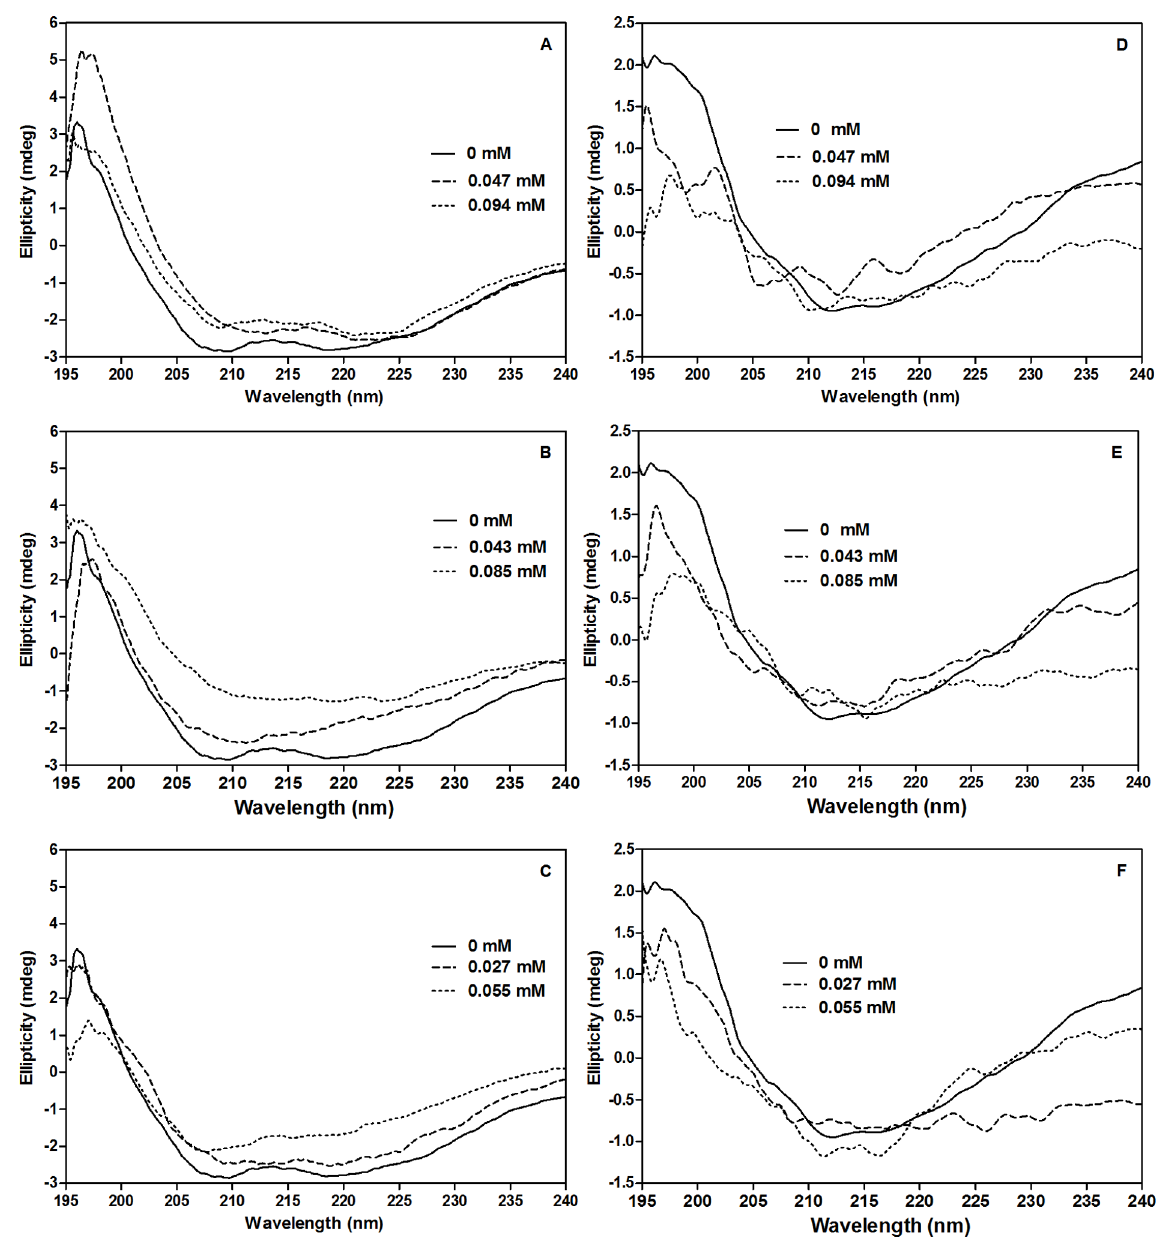
Figure 3. Far-UV circular dichroism spectra of ACE and renin in the presence of peptides. Results of peptide-ACE interactions are showed in A (TF), B (LY), C (RALP), and that of peptide-renin interactions are D (TF), E (LY), F (RALP).